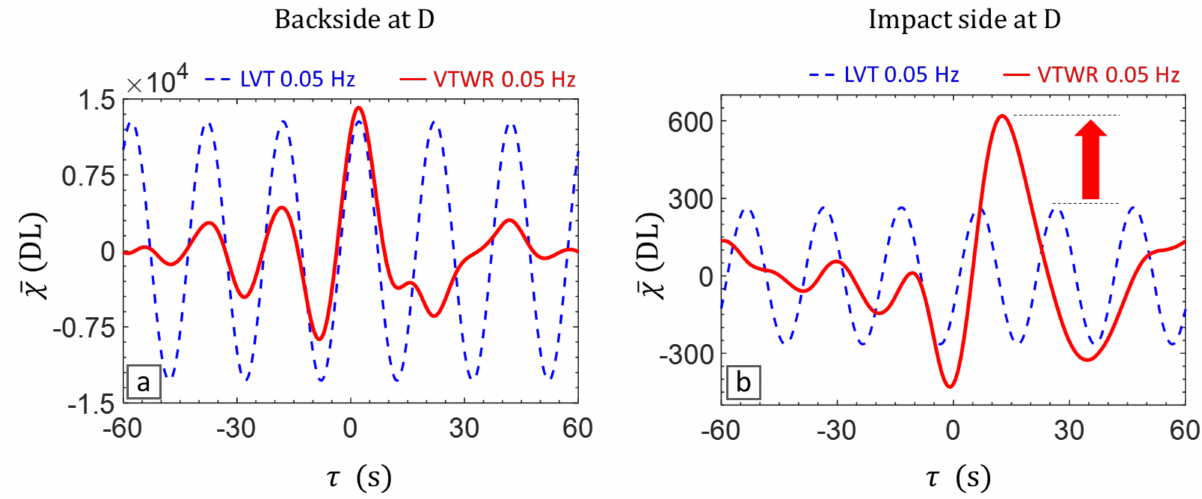
Figure 6. Compressed pulses of LVT and VTWR at AM frequency 0.05 Hz for the defected area D: ( a ) backside (shallow delamination) and ( b ) impact side (deep